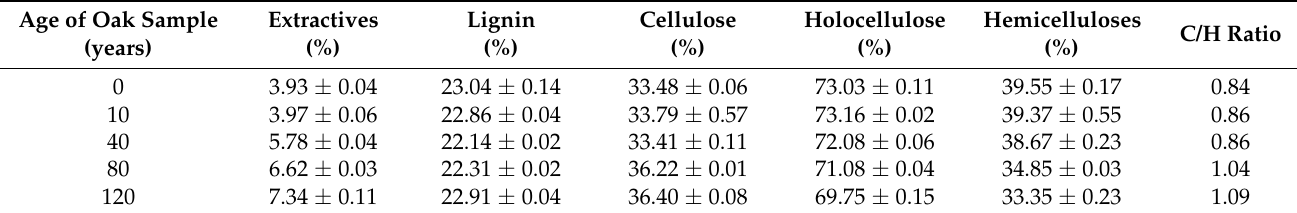
Table 2. Relative content of the main chemical components of oak wood.